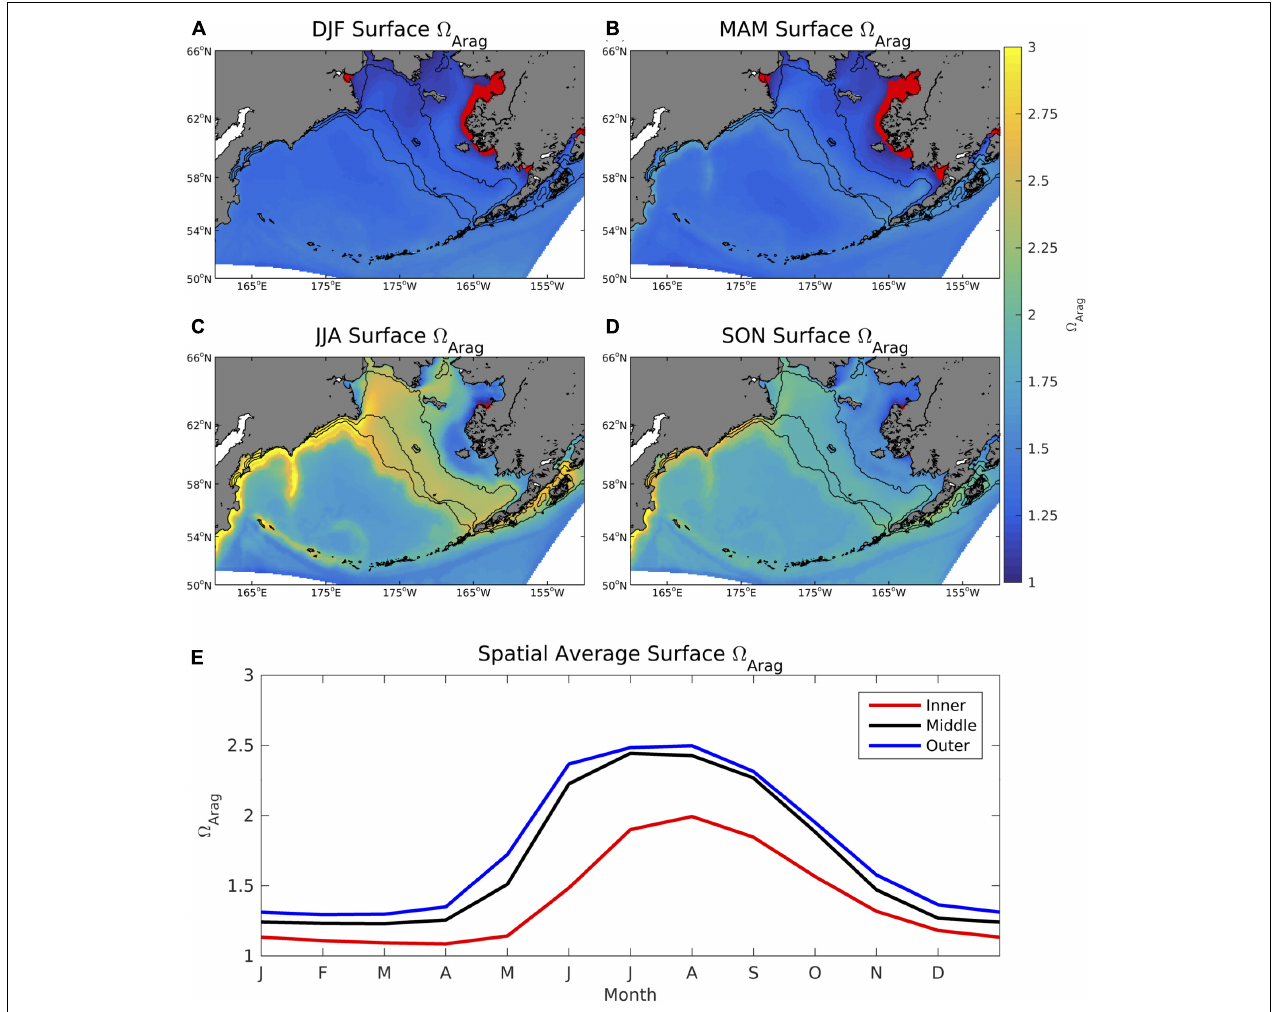
FIGURE 6 | (A–D) Seasonal plots of model surface (cid:127) Arag averaged over the 2003–2012 timeframe and (E) time series of area-weighted spatial mean (cid:127) Arag for the three shelf domains The red dots signify locations where (cid:127) Arag < 1.